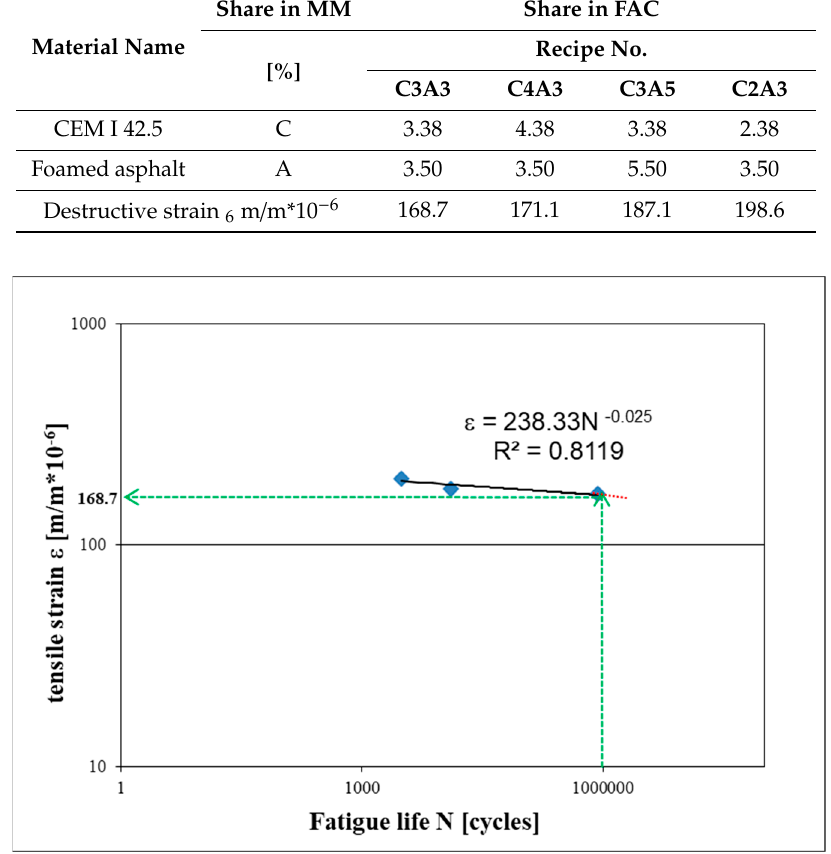
Figure 7. Fatigue curve — FAC.